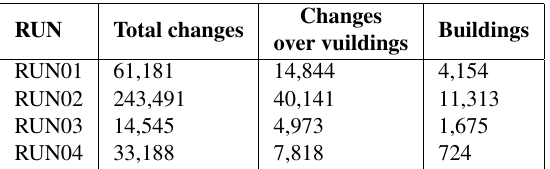
Table 3: Results obtained from each RUN: number of total changes detected by the extended CCD method, number of changes only related to buildings, and number of buildings in- terested by at least one change.